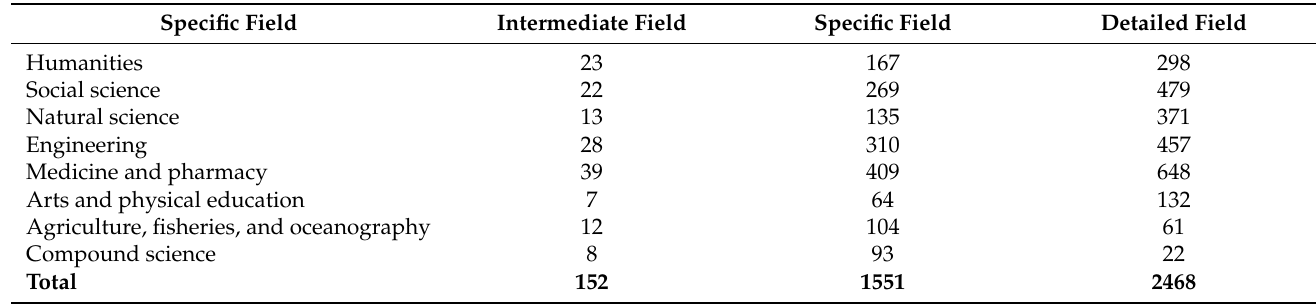
Table 4. Academic research classification system of the NRF of